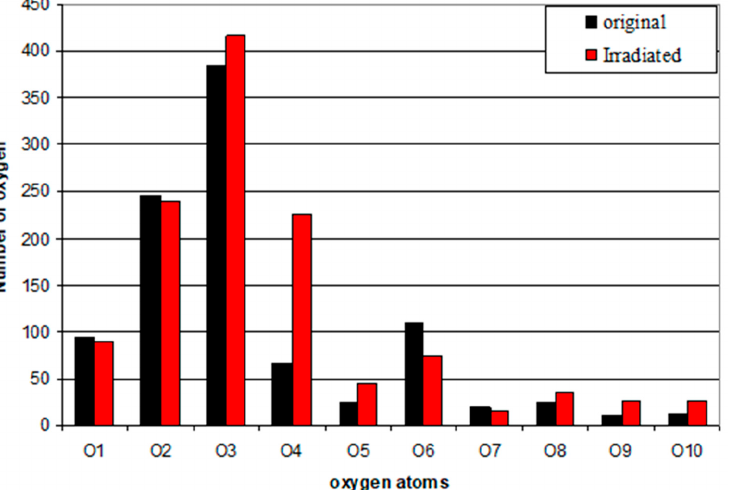
Figure 4. FT-ICR compositional analysis of natural and irradiated crude oil samples as a function of the number of oxygen atoms.